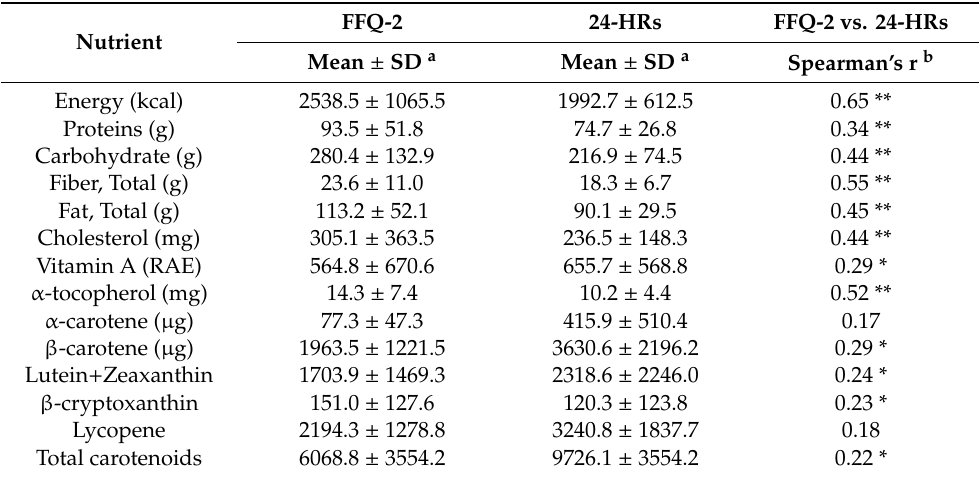
Table 2. Mean nutrient intake estimated by FFQ-2 and by all 24-HRs and Spearman correlation coe ffi cients for FFQ-2 vs. 24-HRs ( N =